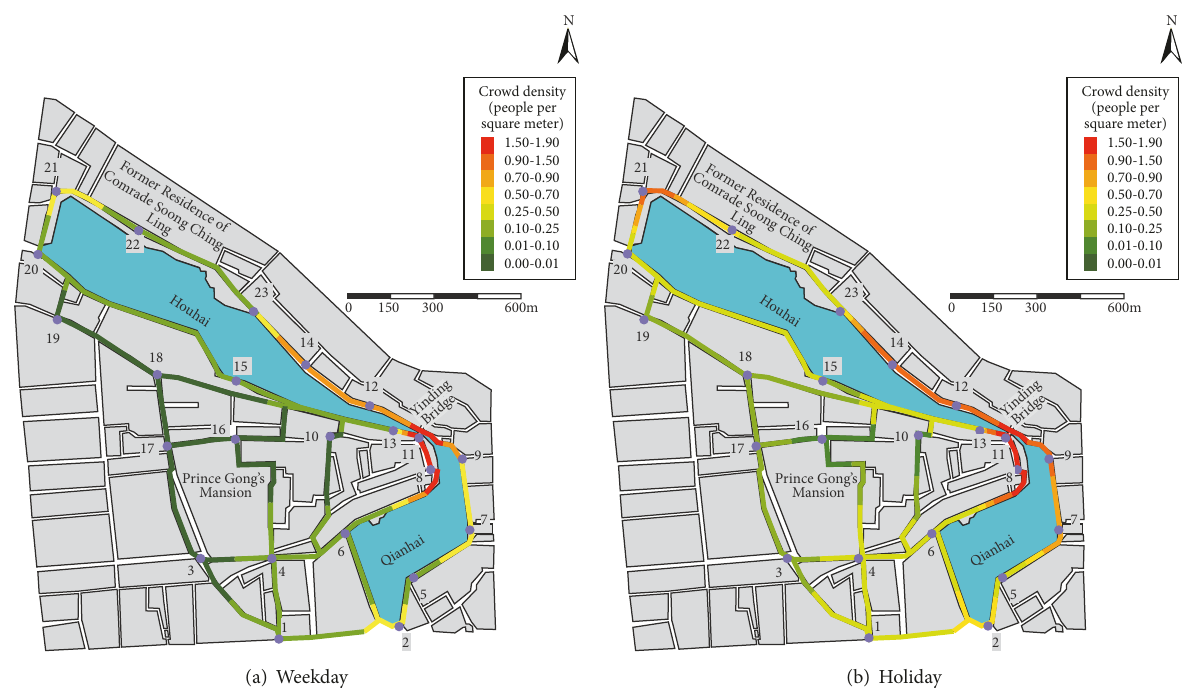
Figure 4: The estimate of the global crowd density by IDWPSB method in the study area on (a) weekday and (b) a holiday.